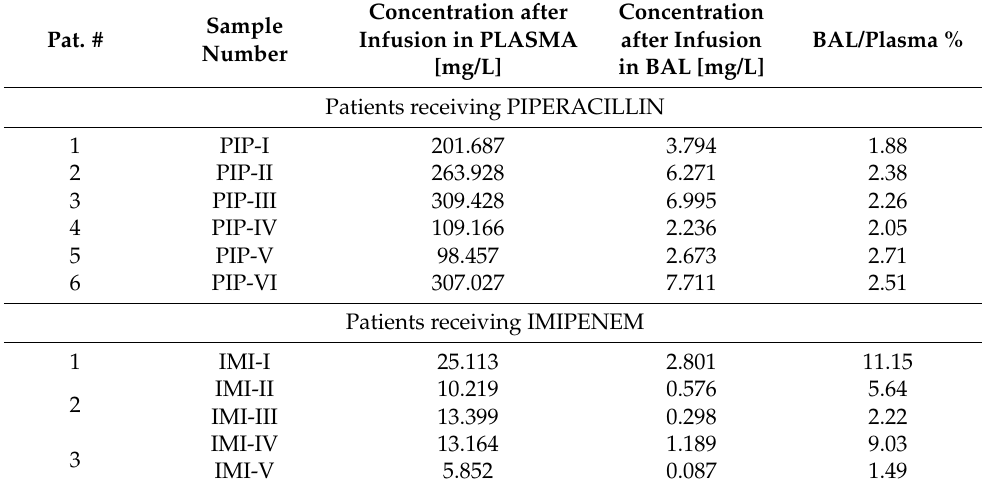
Table 9. The degree of penetration of unbound piperacillin and unbound imipenem to BAL.